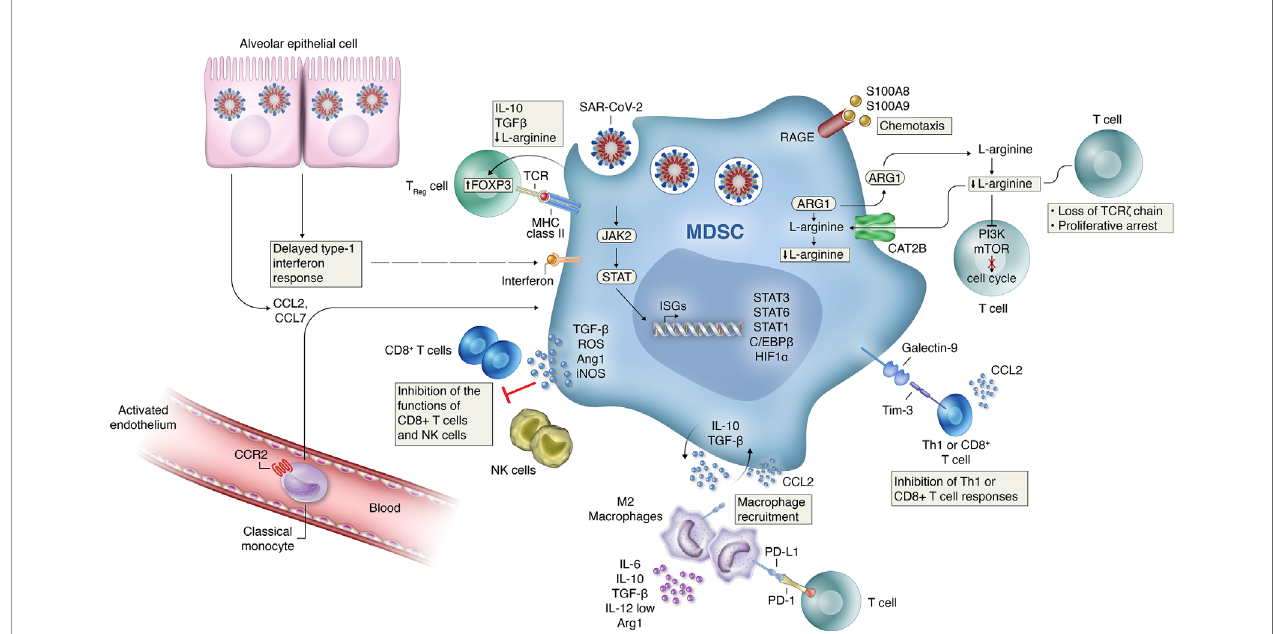
FIGURE 1 | Mechanisms of MDSC-induced immune suppression and development of hyper-in fl ammation activation in COVID-19. Several mechanisms likely contribute to the MDSC-induced immune suppression and development of hyper-in fl ammation activation seen in patients with COVID-19. Delayed production of type I interferon leading to enhanced release of monocyte chemoattractants by alveolar epithelial cells leading to sustained recruitment of MDSCs into the lungs. TGF b and IL-10 release by MDSCs can induce further in fl ammatory programs in resident (M2) macrophages while recruiting in fl ammatory monocytes, as well as granulocytes and lymphocytes from circulation. Signaling through activation of Janus kinase (JAK) – signal transducer and activator of transcription (STAT) pathways is necessary for MDSC expansion. Increased HIF1 a expression can induce the transcription of in fl ammation related genes. The effector mechanisms employed by MDSCs to control immune cell subsets depend on the MDSC subtype with PMN-MDSCs mainly use reactive oxygen species (ROS) and arginase I, whereas M-MDSCs use inducible nitric oxide synthase (iNOS) and arginase I to dampen bystander cells. Increased PDL1 expression on recruited macrophages and MDSCs can directly decrease antigen-speci fi c T-cell activation through interactions with the PD-1 receptor on T-cells. Increased signaling through the Galectin-9 and Tim-3 pathway can lead to the inhibition of Th1 or CD8+ T cell responses. Increased production of TGFb, ROS and L-arginine production by MDSC can inhibit the function of NK and CD8+ T cells during disease progression. Activated MDSCs contribute to the COVID-19 cytokine storm by releasing high amounts of pro- in fl ammatory